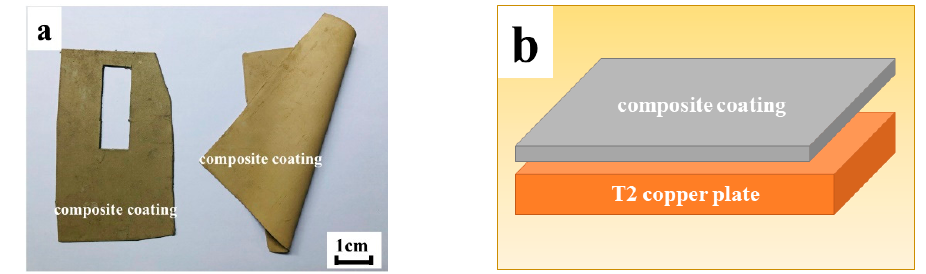
Figure 2. ( a ) Cloth-like composite coating; ( b ) Pre-weld assembly sequence.